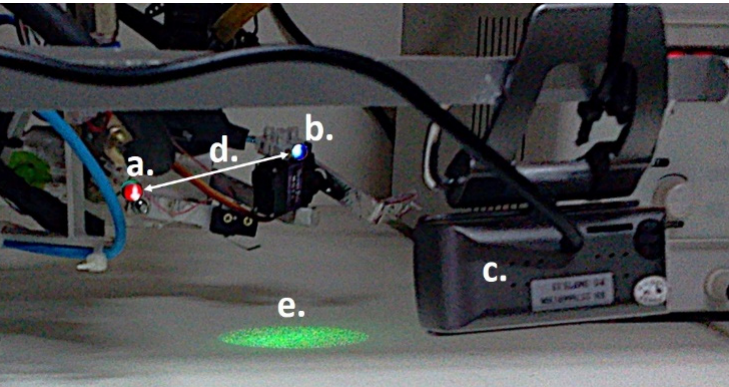
Figure 17. Markers used in frequency analysis: ( a ) Positions of the patella; ( b ) Position of the tip probe; ( c ) Lateral image of the camera; ( d ) Euclidean kneecap-tip distance; ( e ) The Target pointed by LED.